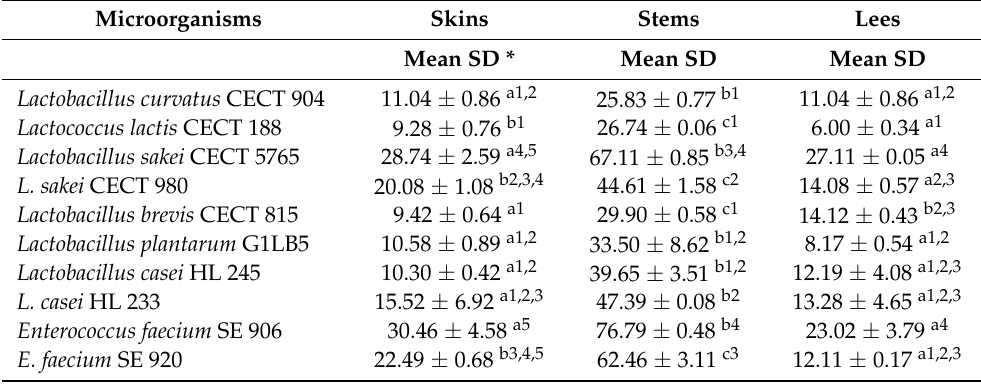
Table 4. Percentage of growth of lactic acid bacteria (LAB) strains, with respect to the positive control, on soluble dietary fibre extracts of skins, stems and